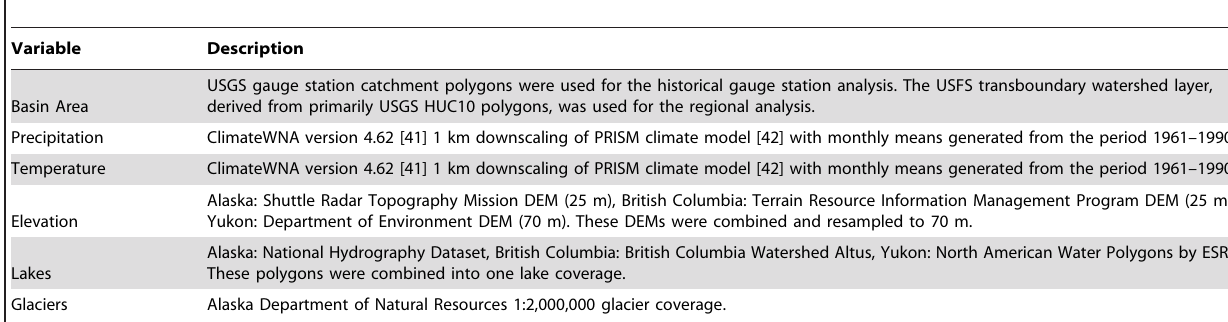
Table 1. Climatic and physiographic geospatial data sources used to develop multiple regression-based monthly discharge models for southeast, Alaska,